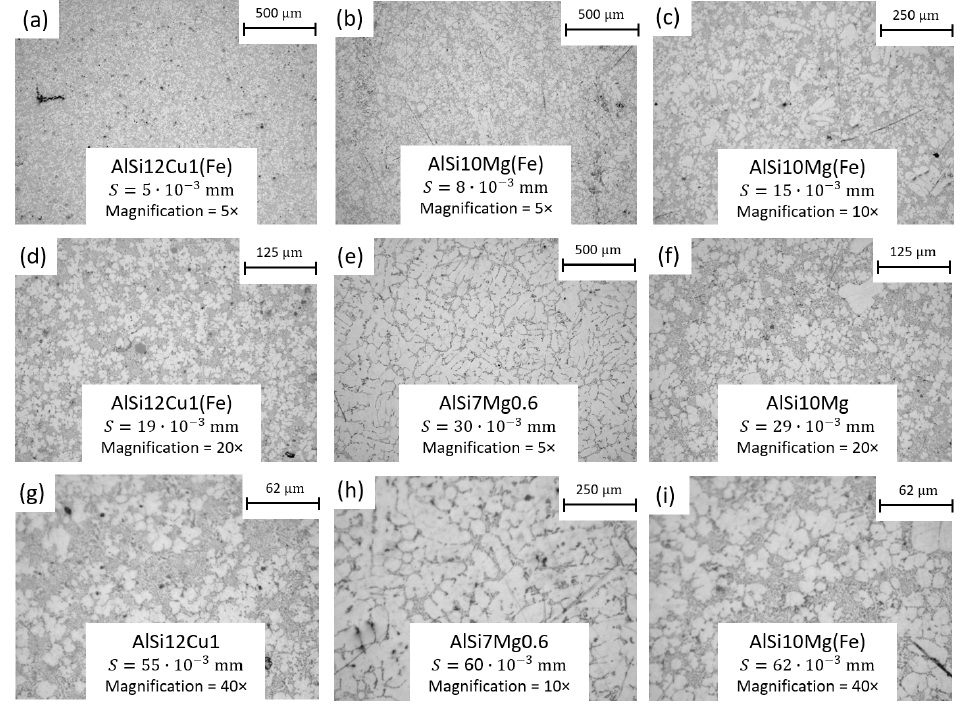
Figure 8. Images of materials that were not used during the training: The images were split into 200 × 200 pixel images following the procedure in Figure 5 and used for the prediction